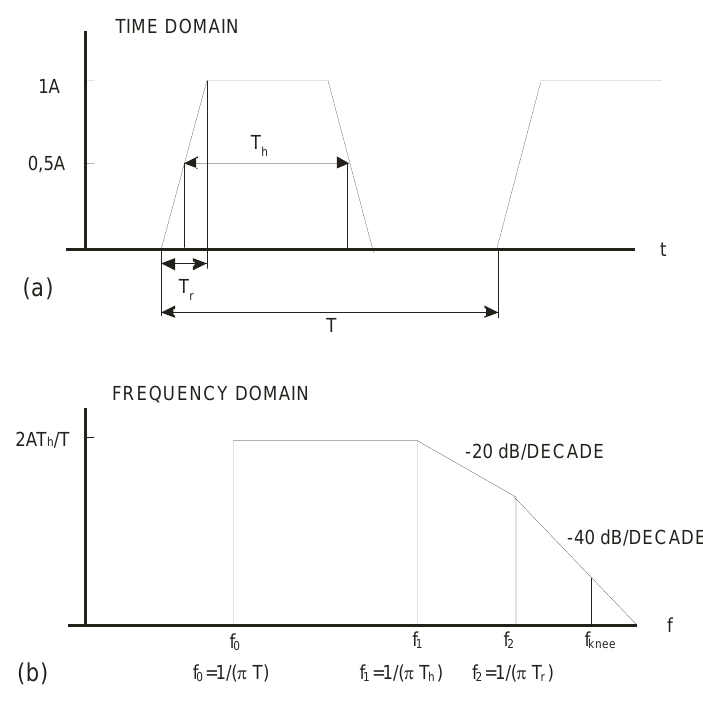
Figure 2. Spectrum of digital periodic